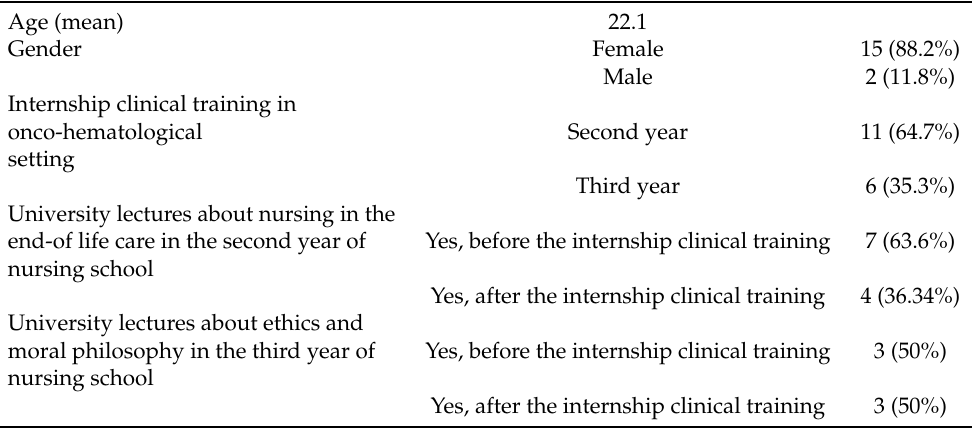
Table 2. The demographic characteristics.